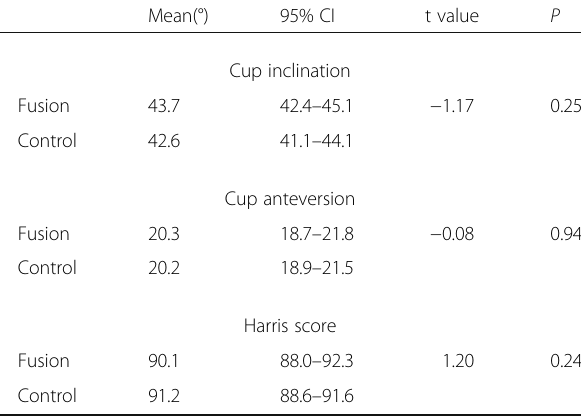
Table 2 The cup inclination, cup anteversion and Harris hip score after THA in the lumbar fusion and control groups were similar without a statistically significant